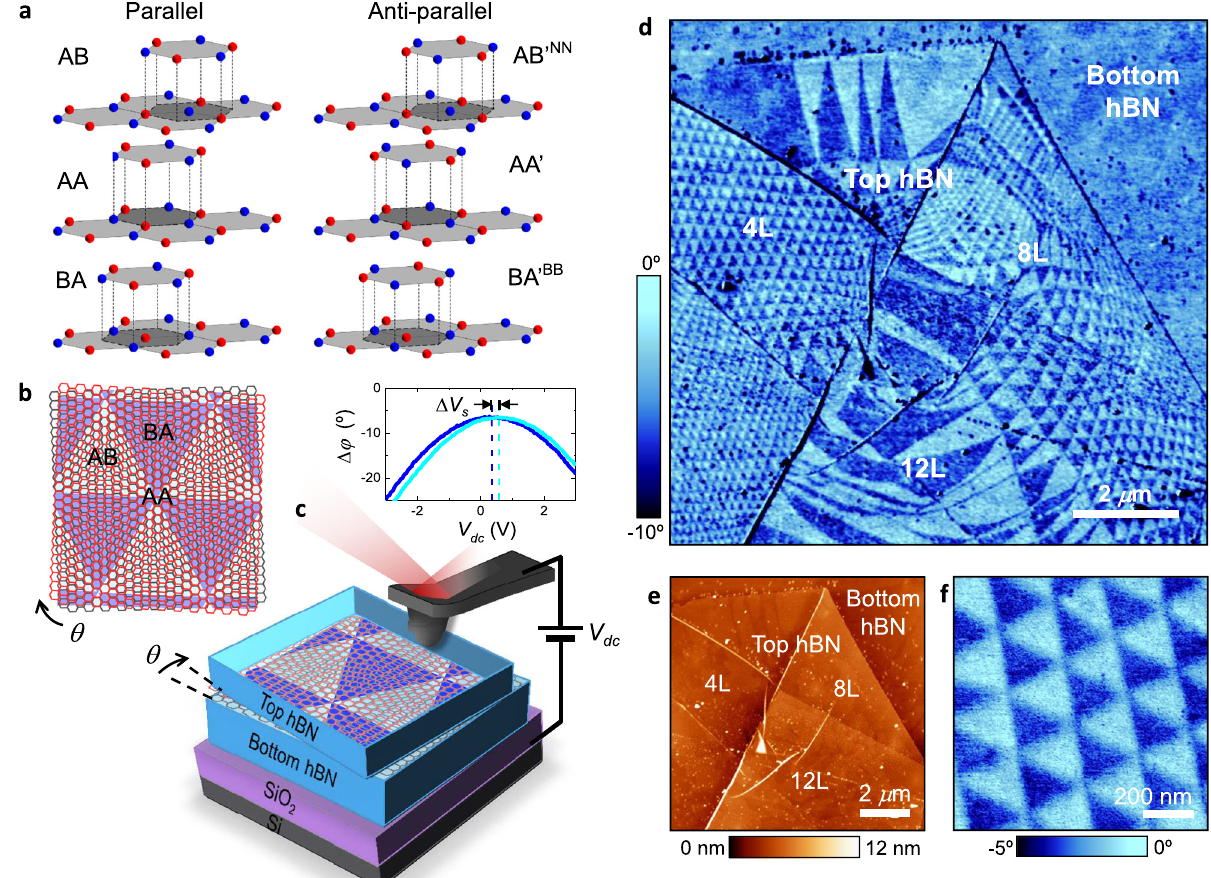
Fig. 1 Electrostatic imaging of charge polarization in marginally twisted hBN. a Illustration of six high-symmetry stacking con fi gurations for the hBN – hBN interface. Nitrogen atoms are shown in red; boron atoms in blue. b Schematic of adjacent hBN atomic layers (red and grey) misaligned by a small angle, θ . Dark and light triangles represent predominantly AB and BA regions, respectively. c Schematic of our experimental setup. Red and grey hexagonal lattices are in the top and bottom hBN, respectively. A voltage bias is applied between the AFM probe and the silicon substrate. Inset: representative dc-EFM curves as a function of the applied dc bias in two adjacent triangular domains. The horizontal shift of the maximum of the curves yields the variation in surface potential, Δ V s , between the domains. d Representative dc-EFM image (phase) of twisted hBN showing large areas with triangular potential modulation. Changes in domains ’ shape and periodicity are due to small changes in θ caused by irregular strain and the wrinkles seen in the corresponding AFM topography image in e . The top hBN crystal has 4-, 8- and 12-layer thick regions. f Zoom-in of a region in d with regular